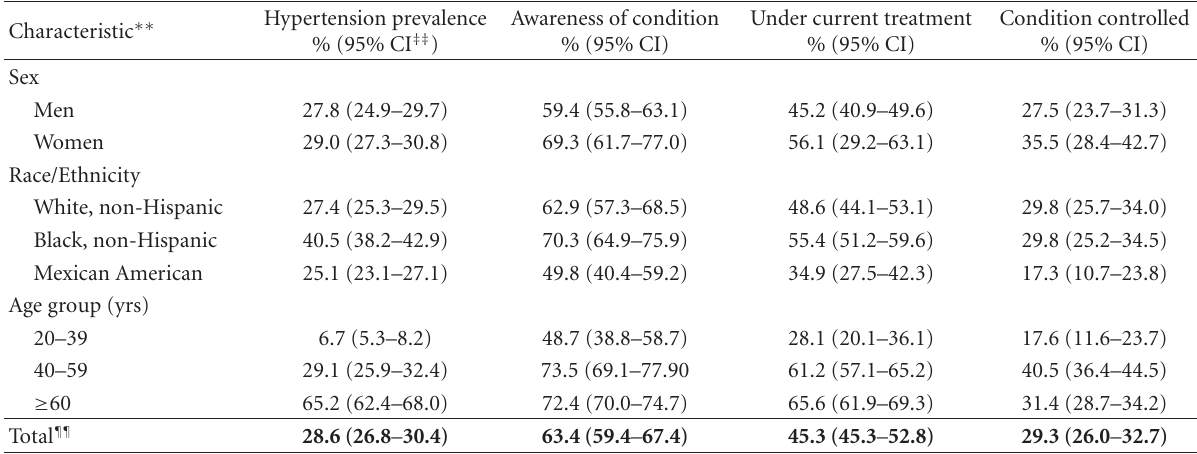
Table 1: Percentage of noninstitutionalized US adults with hypertension ∗ and, among those with hypertension, estimated percentage of persons who are aware of ‡ , treated for § , and in control of their condition ¶ , by sex, race/ethnicity, and age group—United States,